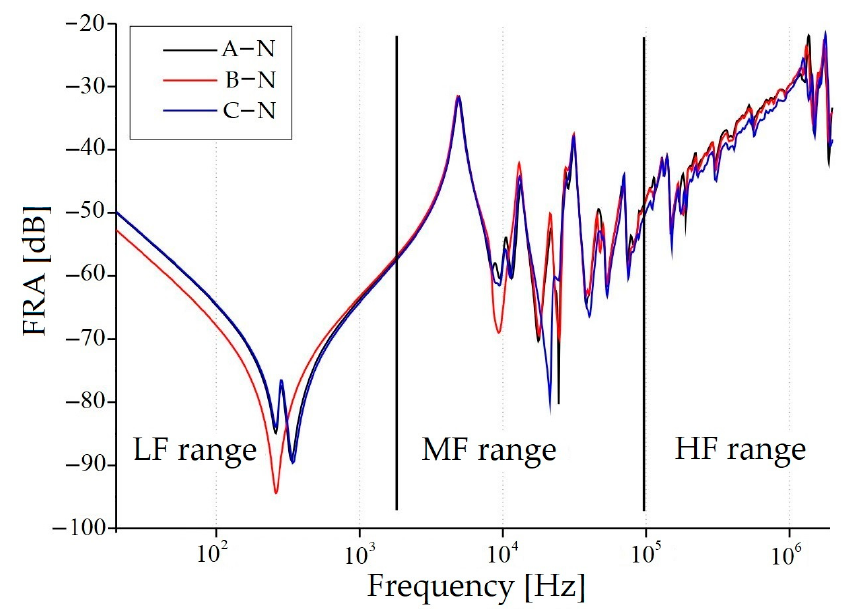
Figure 2. Typical frequency response (FR) curves measured on a three-phase transformer.